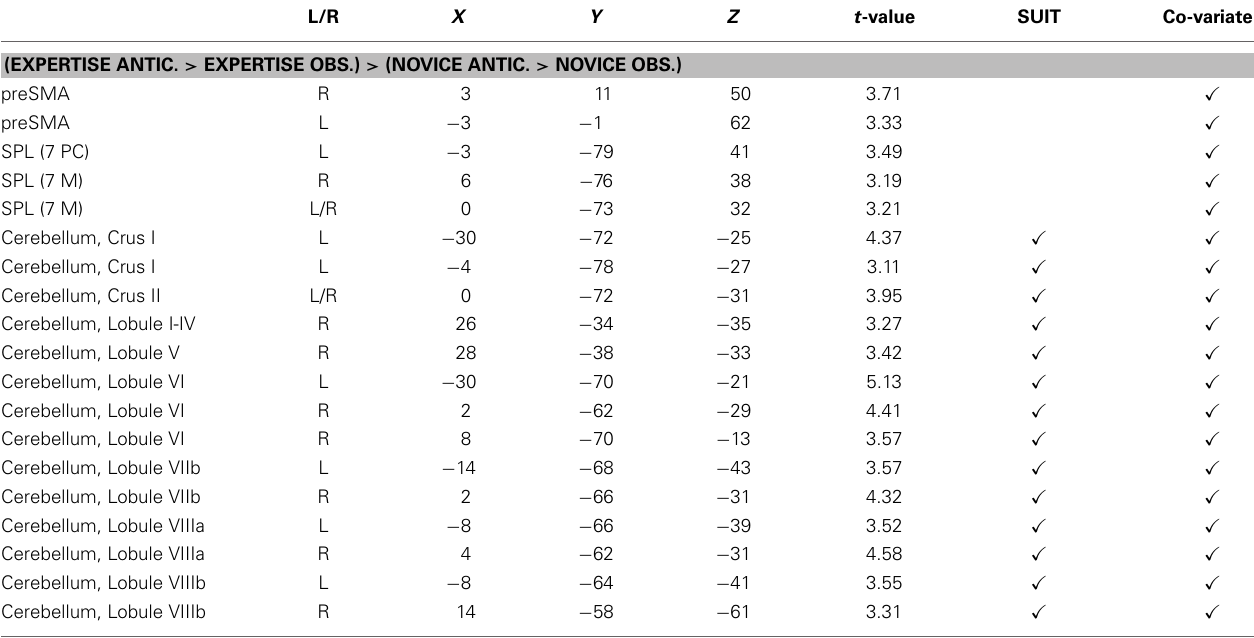
Table 1 | Brain areas identified by the comparison of the respective expertise anticipation condition with the corresponding novice anticipation condition in all 31 participants. L/R X Y Z t -value SUIT Co-variate